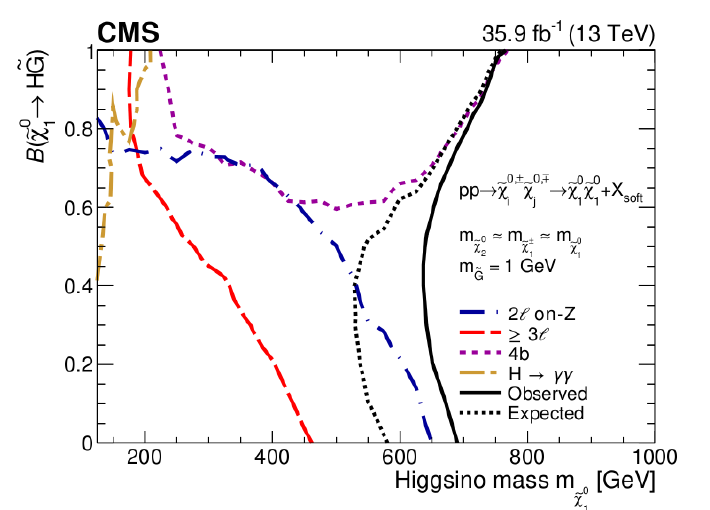
Figure 12 . Observed exclusion contours at the 95% CL in the plane of m